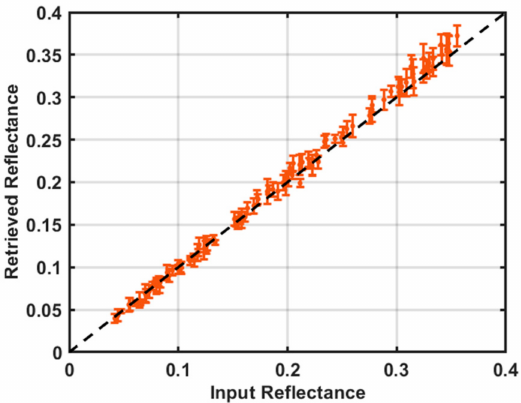
Figure 17. Reflectance measurement results using the pre-computed calibration curves and laser power control. Each point denotes the average retrieved reflectance for five trials at each reflectance value. Error bars correspond to 1 σ . The dashed black line has a slope of